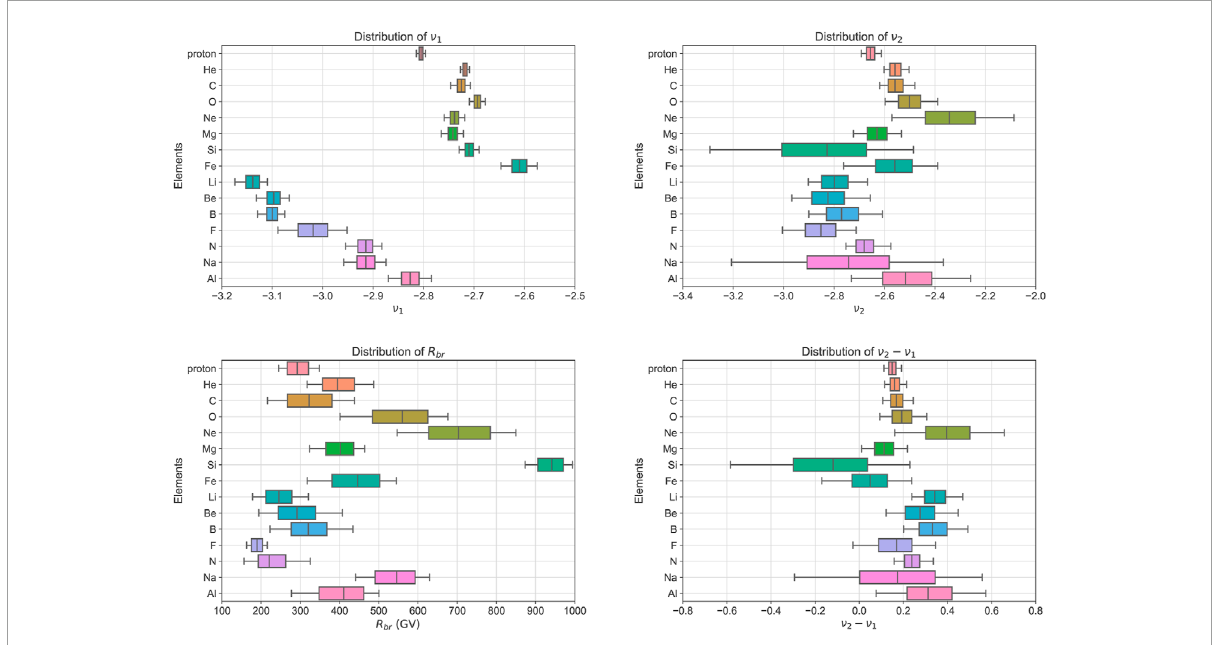
FIGURE 4 Boxplots for ν 1 , ν 2 , R br , and ν 2 − ν 1 ≡ Δ ν . The band inside the box shows the median value of the dataset, the box shows the quartiles, and the whiskers extend to show the rest of the distribution which are edged by the fifth percentile and the 95th